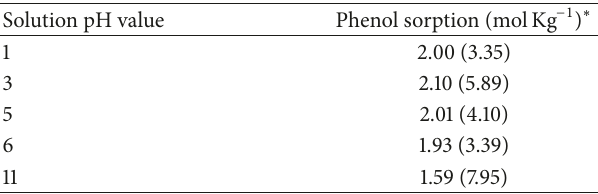
Table 1: pH modification of aqueous solutions and its effect on phenol extraction. Experimental conditions: 50 mL of phenol at